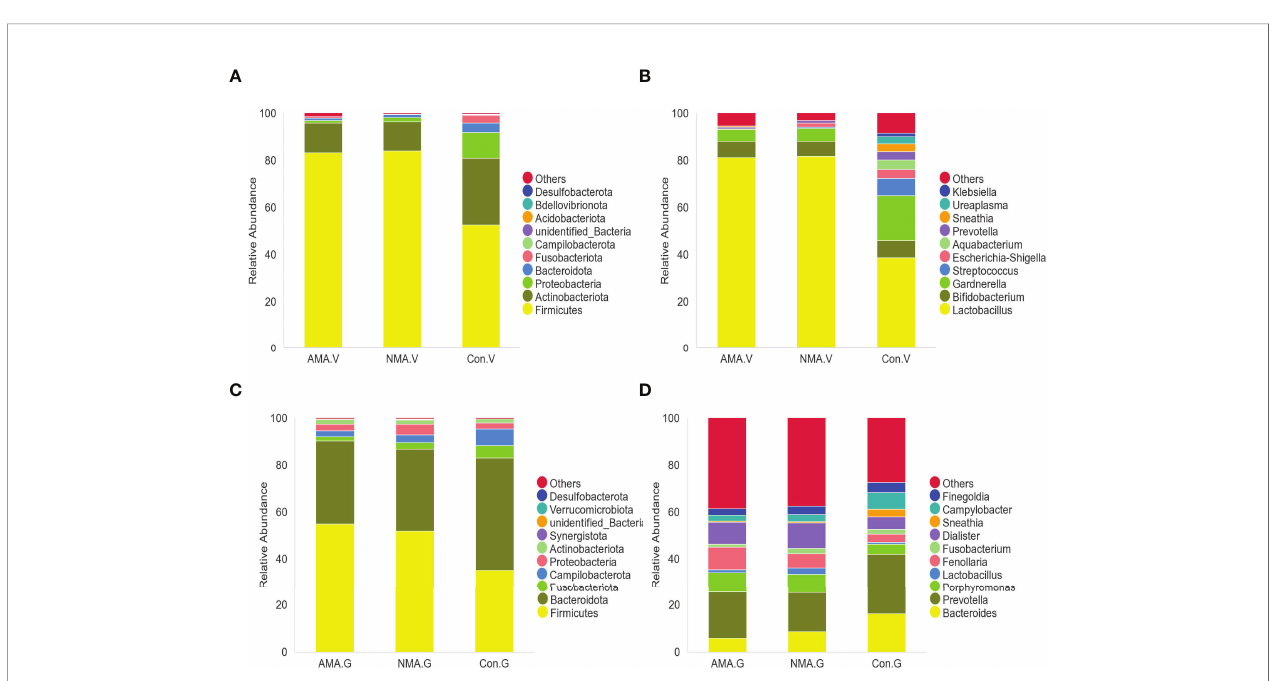
FIGURE 3 | (A) Abundance of species at the phylum level in vaginal microbiota. (B) Abundance of species at the genus level in vaginal microbiota. (C) Abundance of species at the phylum level in gut microbiota. (D) Abundance of species at the genus level in gut microbiota.